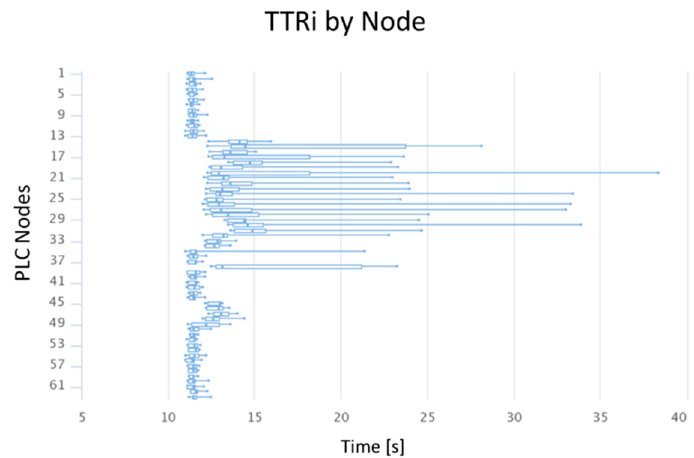
Figure 9. Example of box-and-whisker plot for the TTRAll.